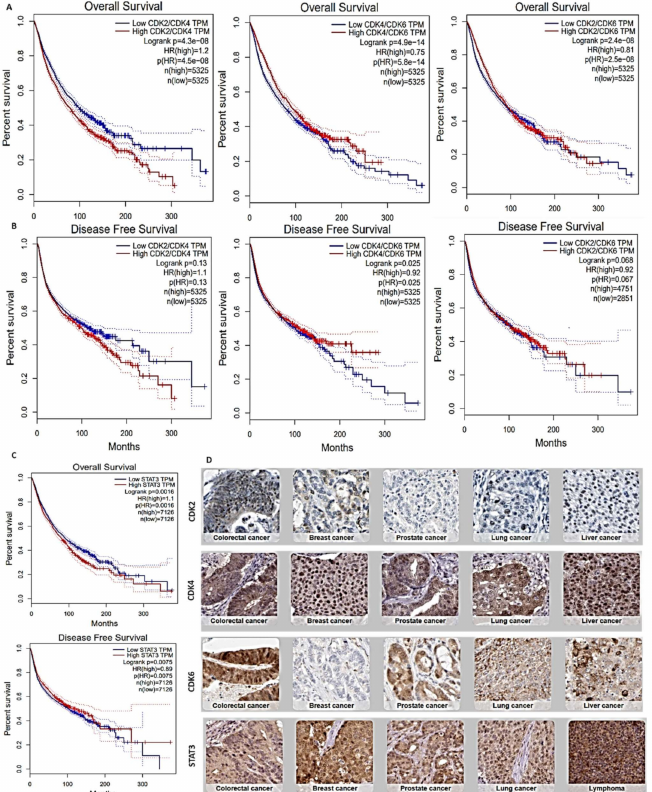
Figure 3. STAT3/CDK2/4/6 over expressions are associated with poor prognoses of cancer patients. Kaplan-Meier curve of ( A ) overall survival (upper panel) and ( B ) disease-free survival (lower panel) of cancer patients with low and high CDK2/4/6 and ( C ) STAT3 expressions across TCGA and GTEx datasets. Higher RNA expression profiles of STAT3/CDK2/4/6 correlated with low overall survival and disease-free survival of cancer patients. ( D ) Representative immunohistochemistry of STAT3/CDK2/4/6 staining across the Human Protein Atlas (HPA) database shows high intensities of CDK2 (antibody: CAB013115), CDK4 (antibody: CAB013116), CDK6, (antibody: HPA002637) and STAT3 (antibody: HPA001671) expressions in clinical samples. Table 1. STAT3/CDK2/CDK4/CDK6 immunohistochemistry profile of cancer cohorts from human protein atlas database (HPA). Cancer